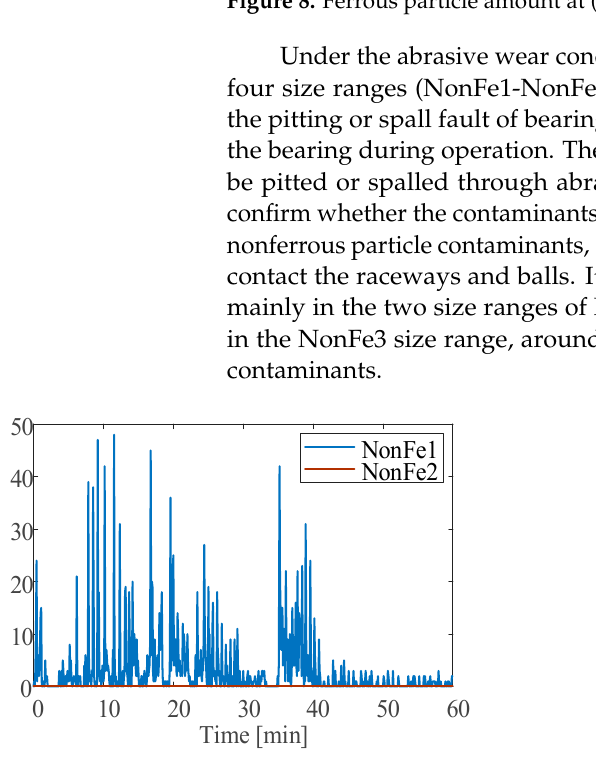
Figure 9. Nonferrous particles amount at abrasive wear. The amount of the first six ferrous particle size ranges (Fe1–Fe6) at abrasive wear is shown in Figure 10. When the nonferrous particle contaminants are introduced, the size ranges of the ferrous particles are increased. The appearance of the max amount of Fe3 (65 µm) particles is slightly behind the occurrence of the maximum amount of NonFe3. The occurrence time of the maximum amount of Fe5 and Fe6 particles is basically the same as the occurrence time of the maximum amount of NonFe3 particles. This is due to when producing pitting or spalling after nonferrous particle contaminants enter the bearing, the spalled ferrous particles will not leave the bearing immediately with the forced lubrication, but will stay in the bearing for some time. During this period, the large-size ferrous particles are crushed by the rotation of the bearing, and the particle size gradually de- creases.